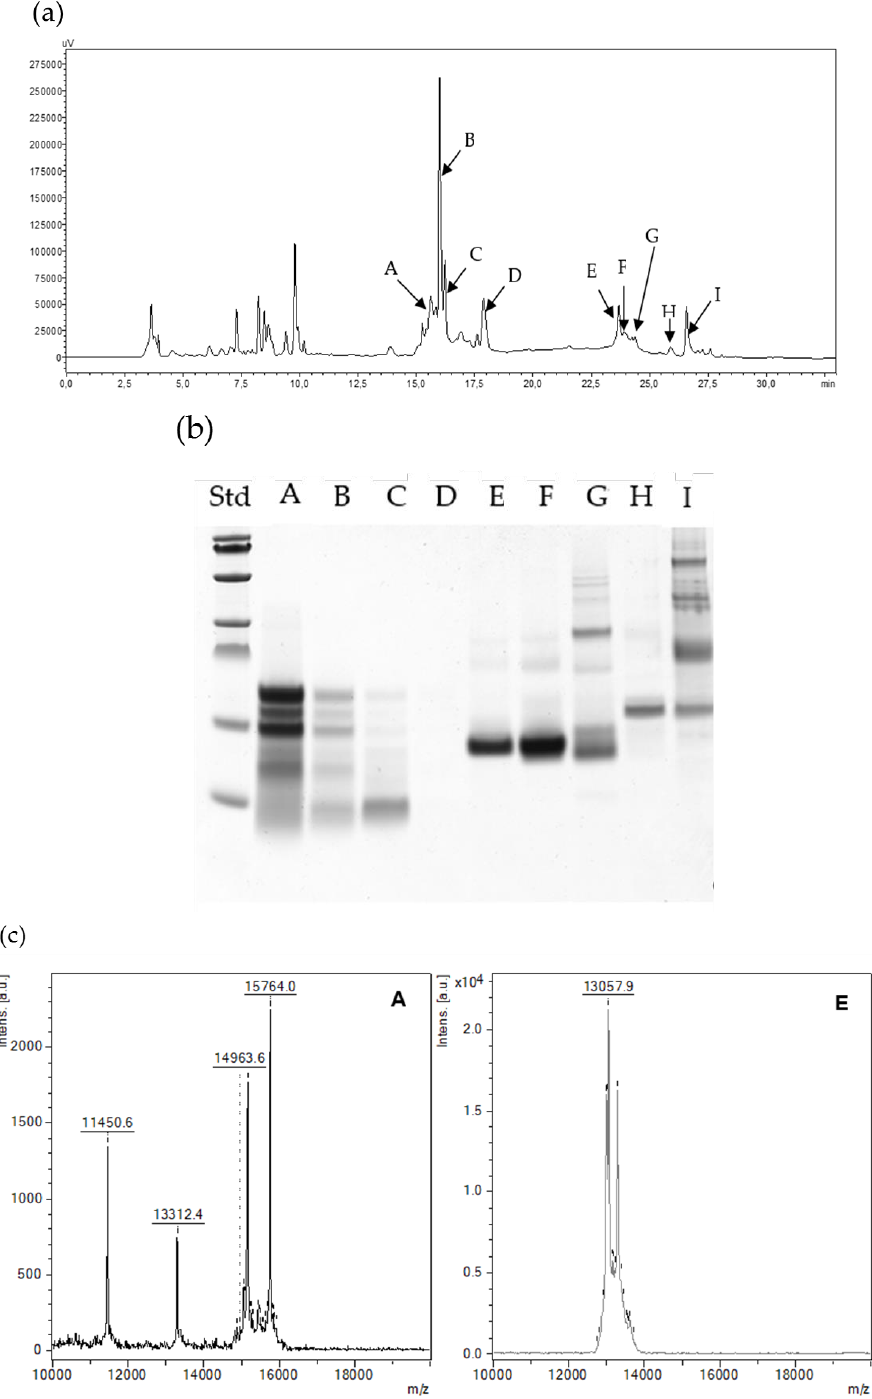
Figure 2. Response surfaces of ( a ) and ( b ) protein concentration and ( c ) and ( d ) amylase activity inhibition as function of salt concentration and pH with Julius and Poncticus , respectively. Extraction time is fixed at central point (105 min).